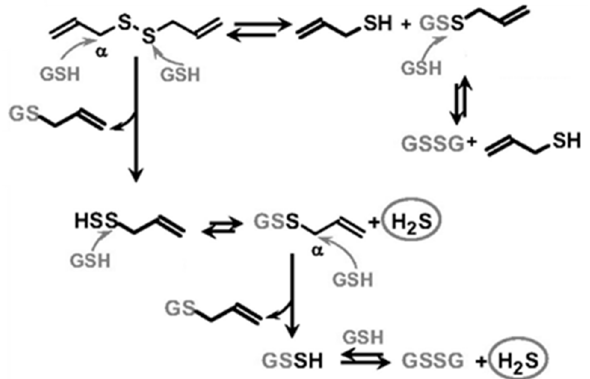
Figure 2. Reaction between diallyl disulfide and glutathione (GSH), yielding the formation of H 2 S and perthiols, which generate another molecule of H 2 S and glutathione disulfide